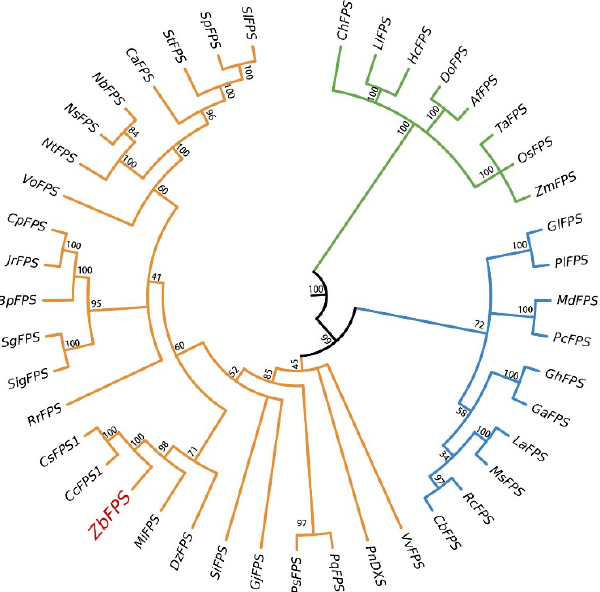
Figure 1. Results of phylogenetic analysis of ZbFPS and other plants. The numbers in the figure represent the genetic distance. Bootstrap values are shown as a percentage of 1000 replicates. Dif- ferent colors represent different clades. ZbFPS is marked by green dots. The GeneBank sequence